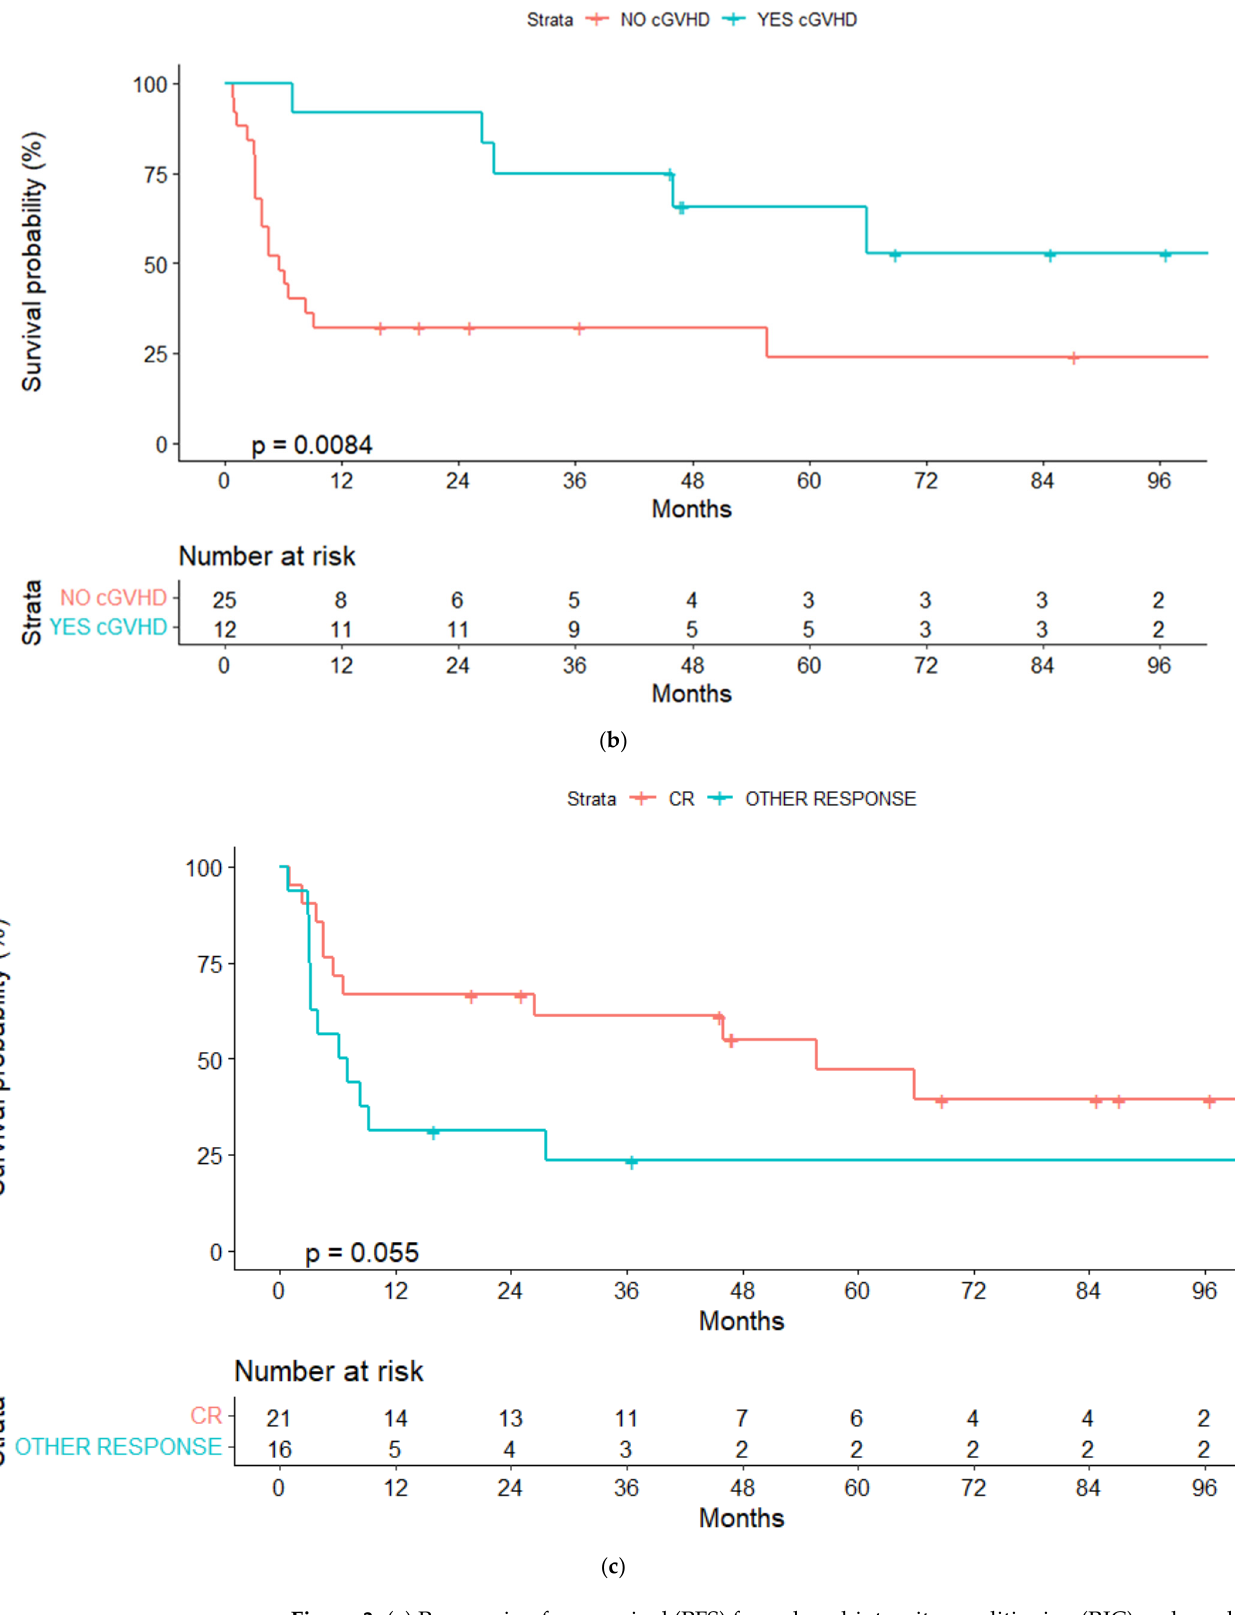
Figure 3. ( a ) Progression free-survival (PFS) for reduced-intensity conditioning (RIC) and myeloablative conditioning (MAC) regimens. ( b ) PFS according to chronic graft-vs-host disease (cGVHD). ( c ) PFS according to lymphoma status pre-alloSCT, complete response (CR) or other response.